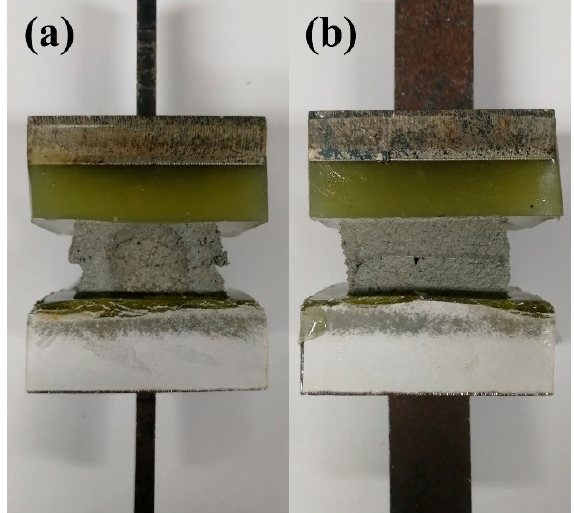
Figure 6. Schematic of sample preparation for tensile bond strength. ( a ) is the front view of the sample and ( b ) is the side view of the sample.